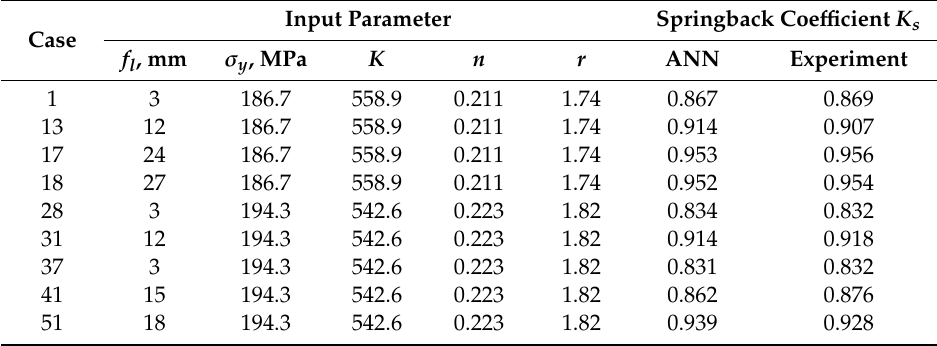
Table 5. Quantitative comparison of the springback coe ffi cients Ks determined experimentally and by MLP